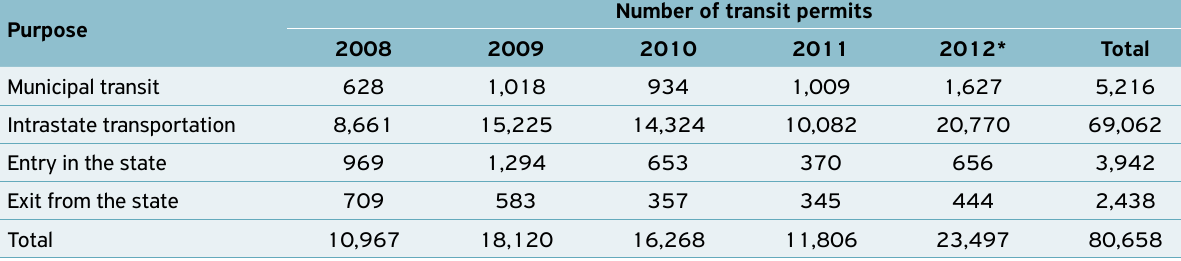
Table 5. Number of poultry transit permits issued in the state of Sergipe, 2008–2012.